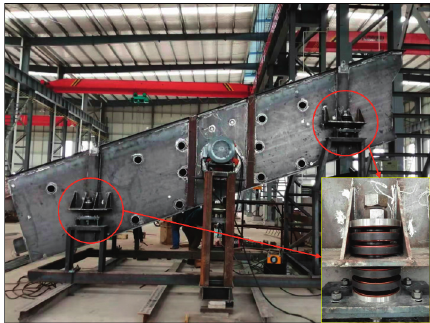
Figure 1: Vibration screen and disc spring